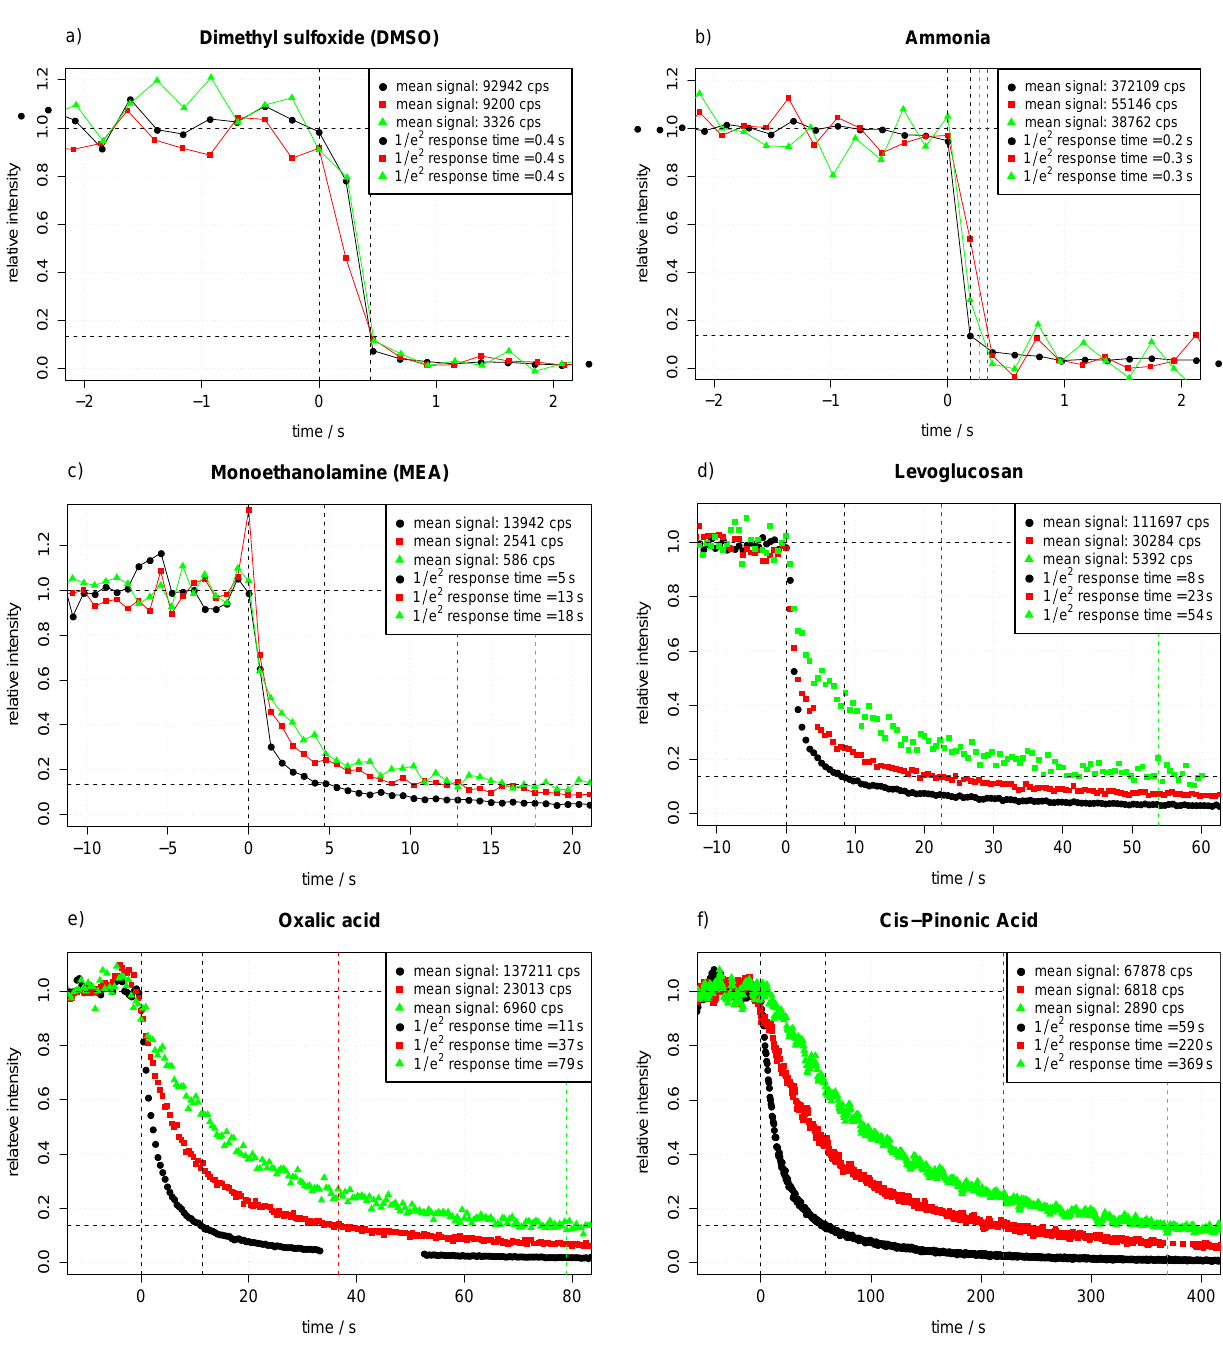
Fig. 4. HT-PTR-MS response times for dimethyl sulfoxide ( m/z 79), ammonia ( m/z 18), monoethanolamine ( m/z 62), levoglucosan ( m/z 85; fragment – see text), oxalic acid ( m/z 91), and cis-pinonic acid ( m/z 167; fragment – see text).